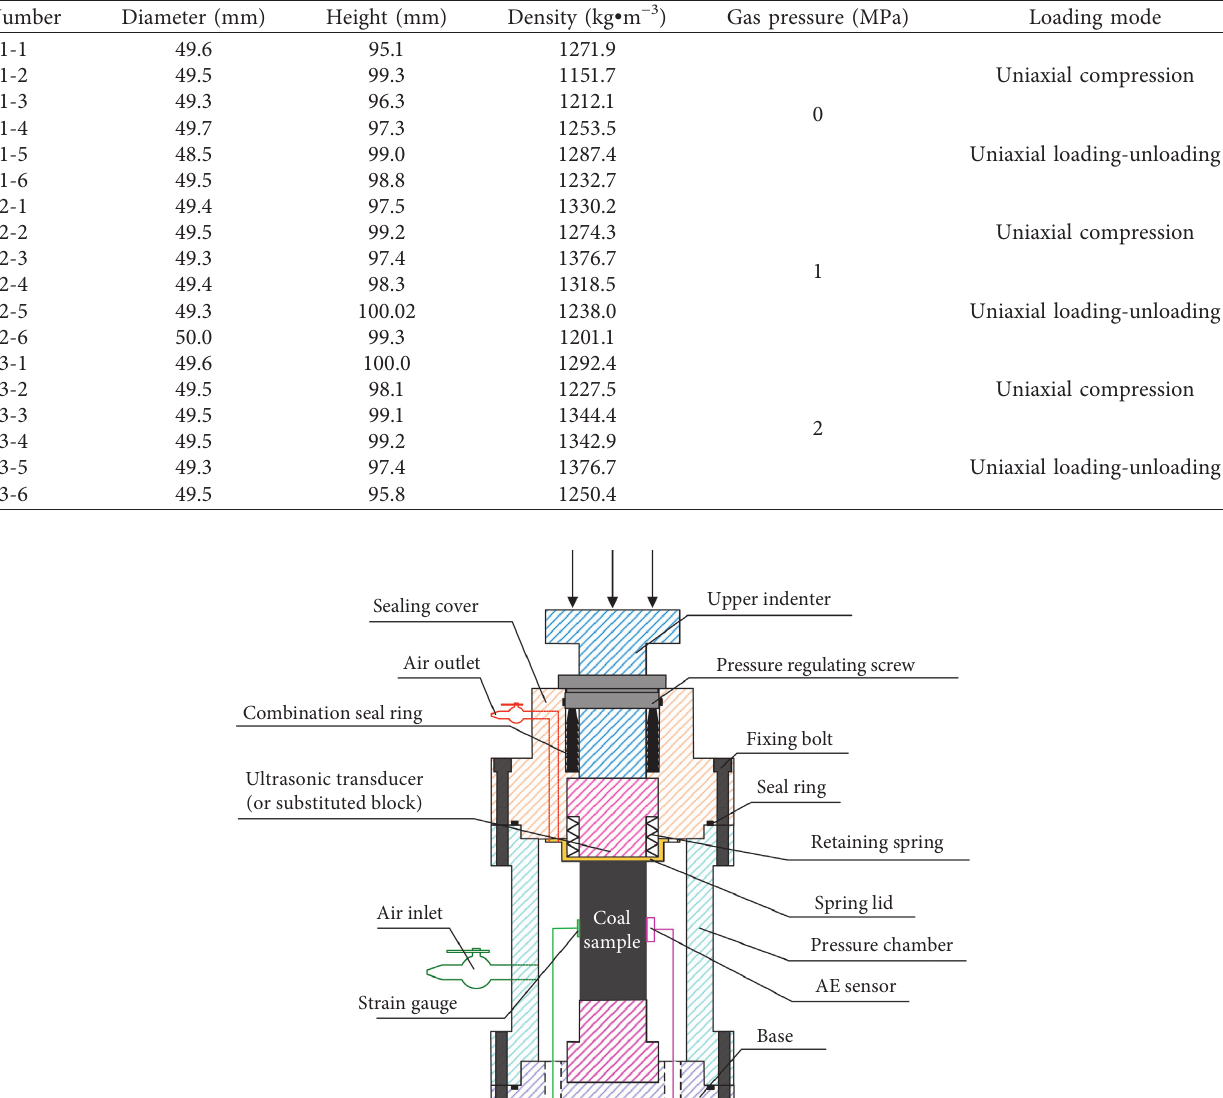
Table 2: Record of coal sample grouping and physical properties of coal